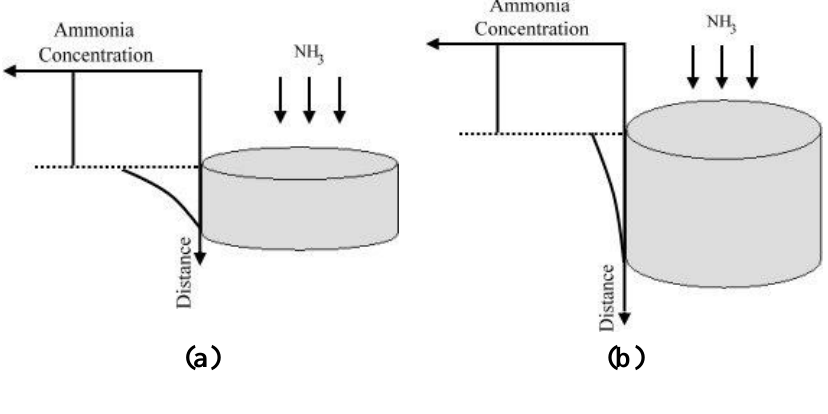
Figure 10. Schematic sketches which show the diffusion effect across the sensing